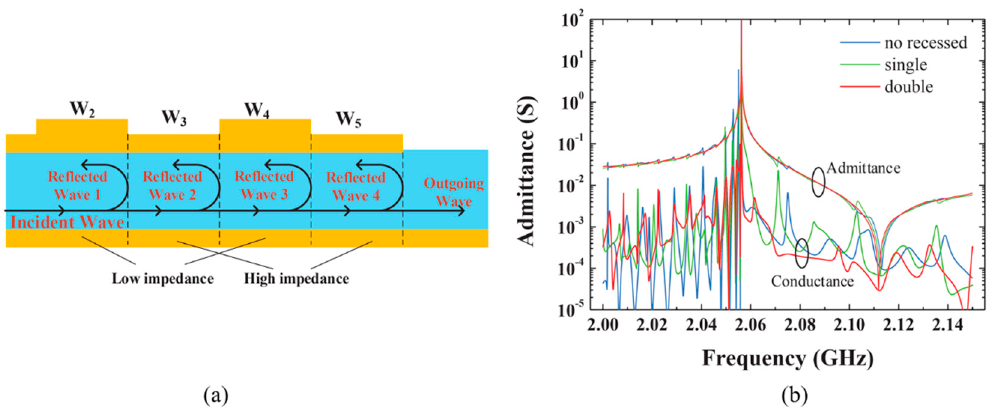
Figure 12. ( a ) BAW resonator with double raised frame [91]. ( b ) Admittance curves of structures with the double raised frame, the single raised frame, and without the recessed frame [91]. Reproduced with permission from [91].